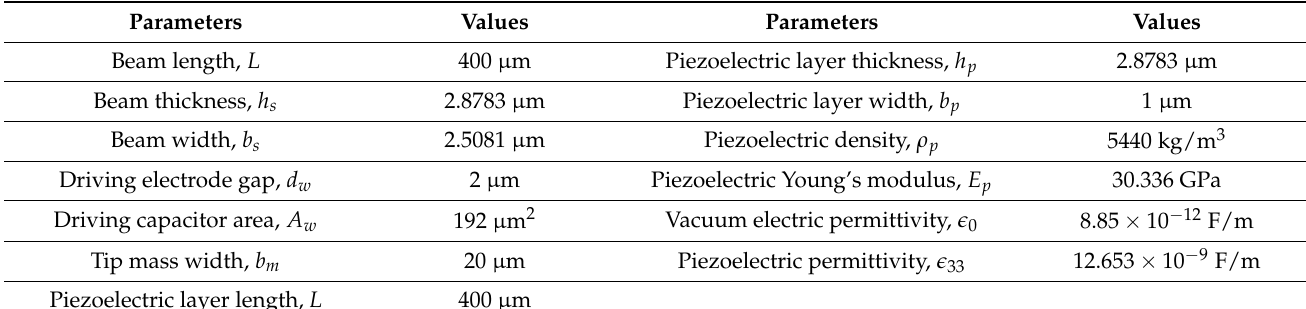
Table 2. Microbeam and piezoelectric parameters [56,57,62].